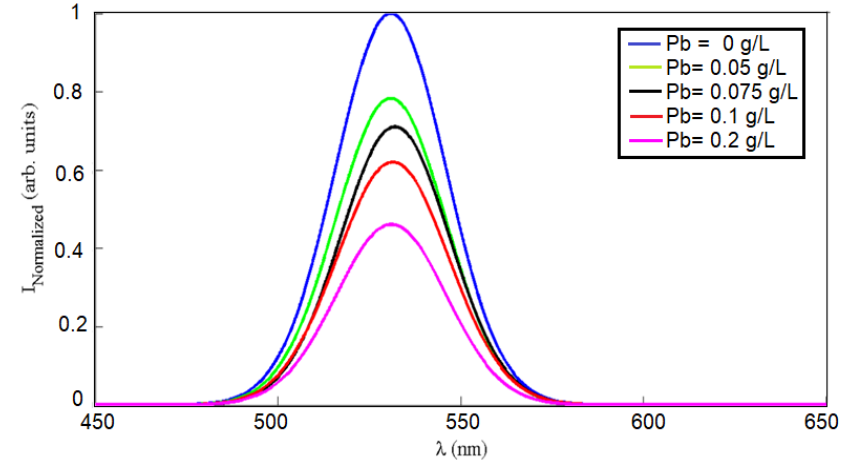
Figure 6. Fluorescene intensity quenching of in-situ gold-ceria nanoparticles at different Pb concentrations.